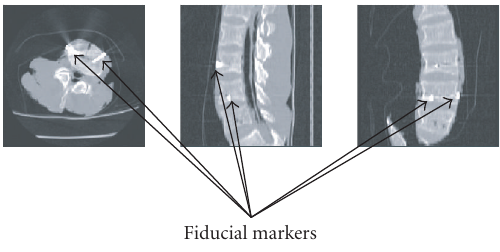
Figure 5: 3D CT with visible fiducial markers transversal (left), sag- ittal (center), and frontal (right) CT slices.